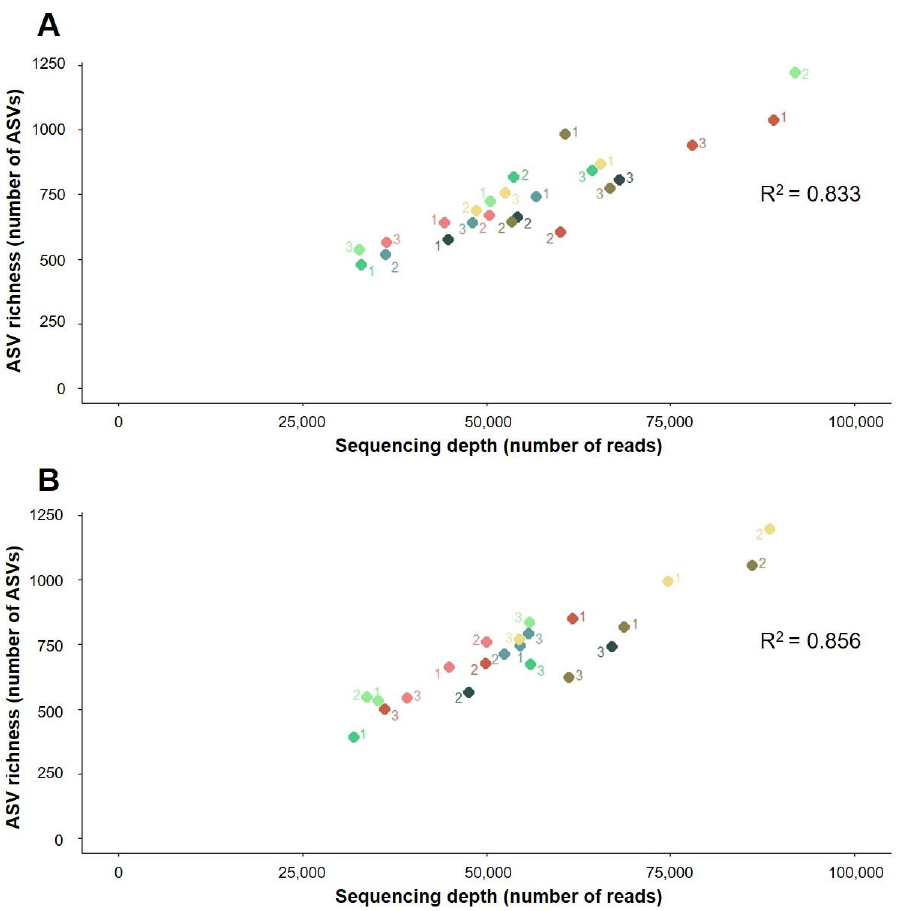
Figure 1. Effect of sequencing depth on the taxonomic richness discovery from ( A ) the Scottish Agricultural College soil (Craibstone, Scotland) and ( B ) La Côte de Saint André soil (France). Green: Maxwell 1 modification of the prototype Maxwell RSC Fecal Microbiome DNA Kit (Promega). Red: Maxwell 2 modification of the prototype Maxwell RSC Fecal Microbiome DNA Kit (Promega). Blue: Phenol/Chloroform. Yellow: DNeasy PowerSoil Kit (QIAGEN). The taxonomical richness measured in each sample was determined and plotted as a function of the sequencing depth. For each method/soil pair, triplicates (labelled 1, 2, and 3) were sequenced twice and plotted in the graph. Lighter colours represent the first sequencing run, and darker colours represent the second sequencing run. Correlation p -value: 5.15 × 10 − 10 (Scottish Agricultural College soil) and 7.38 × 10 − 10 (La Côte de Saint André soil).